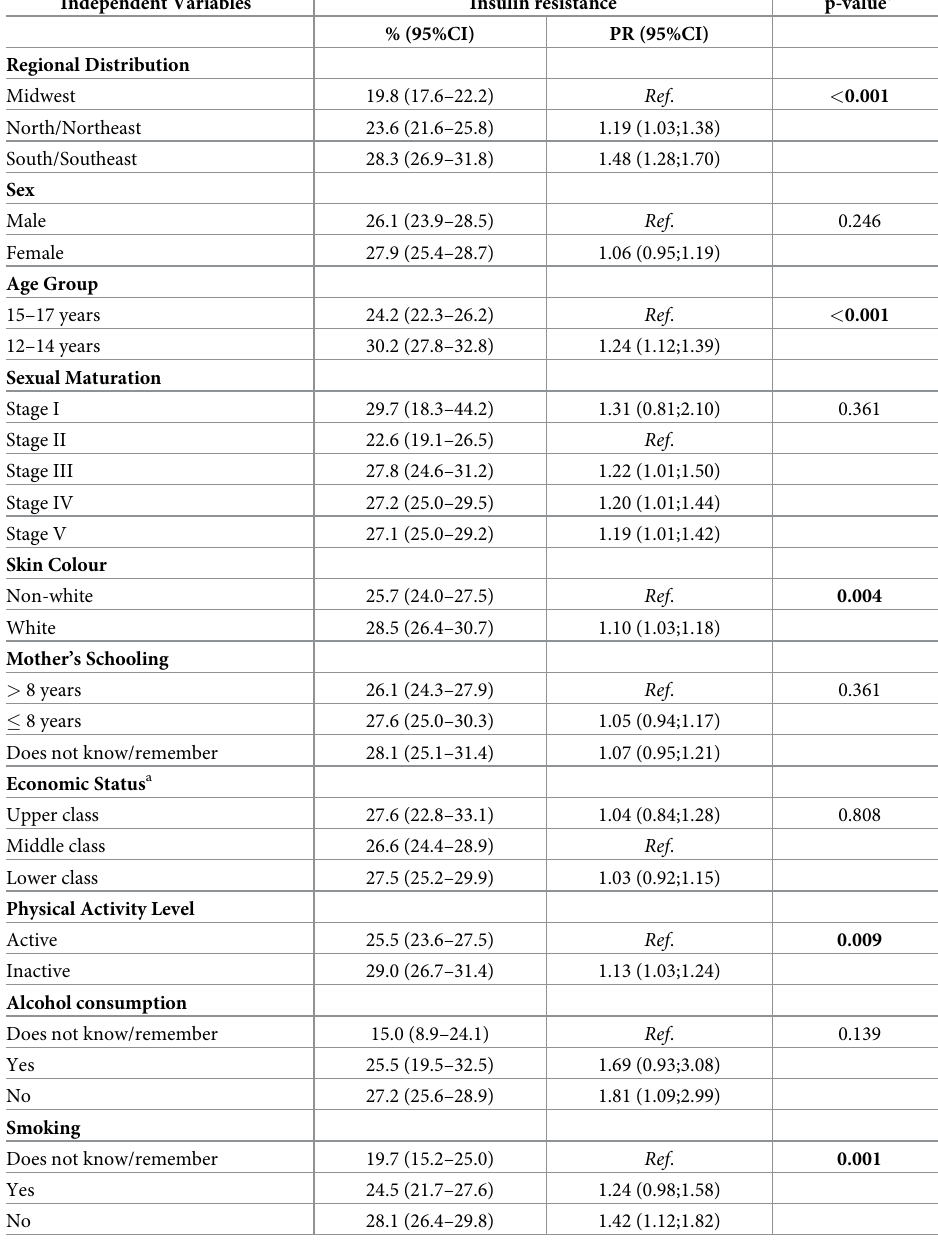
Table 4. Prevalence of insulin resistance, prevalence ratios, and confidence intervals according to demographic, socioeconomic, and lifestyle characteristics of Brazilian adolescent students. ERICA Study,